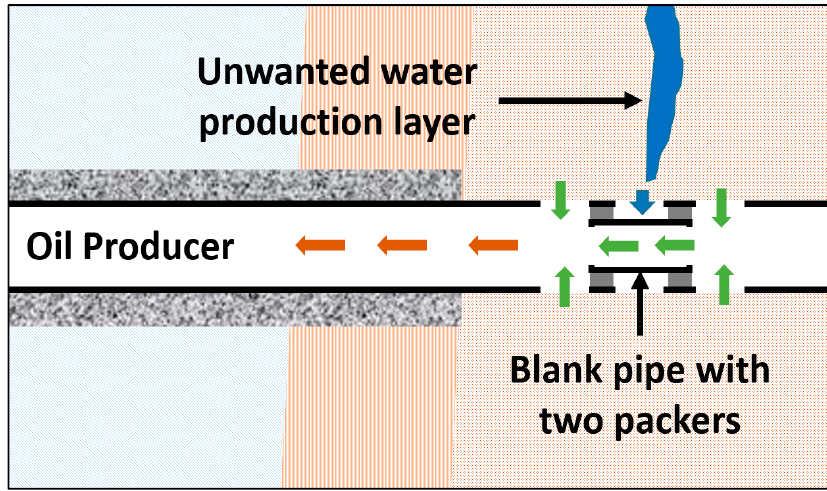
Figure 7. Two packers above and below a blank pipe to shut off the production of water from the middle and upper intervals without compromising other oil production zones.